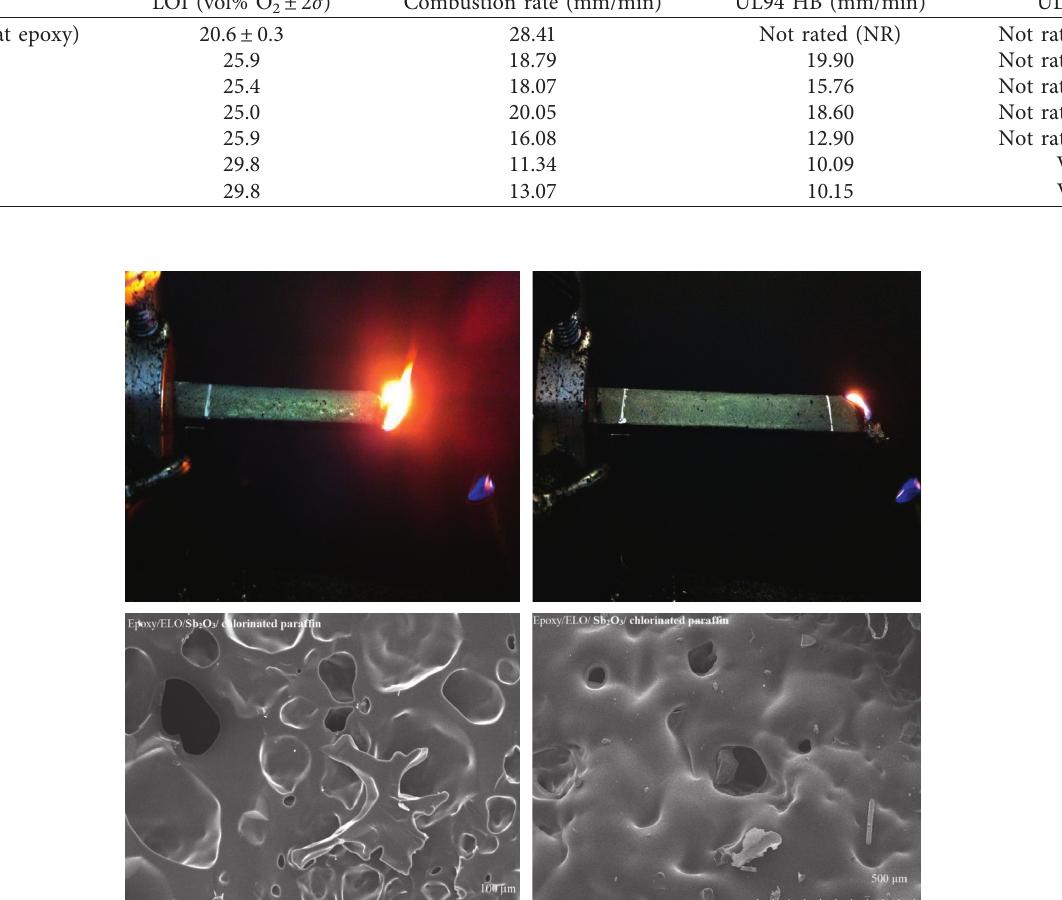
Figure 8: SEM morphologies of the residues of composite epoxy/epoxidised linseed oil/Sb alcohol burner (UL